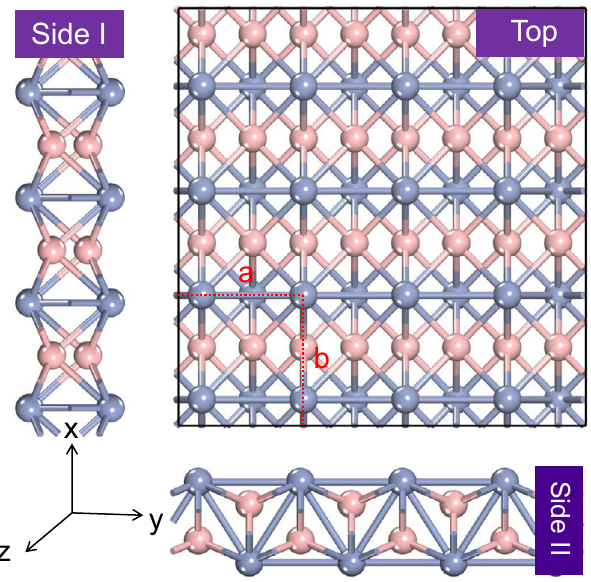
Fig. 1 Geometrics of MBenes. Top and side views of the schematic structure of a M 2 B 2 -type MBene. The red dashed lines denote a unit cell. The pink and blue balls represent boron and transition metal atoms,